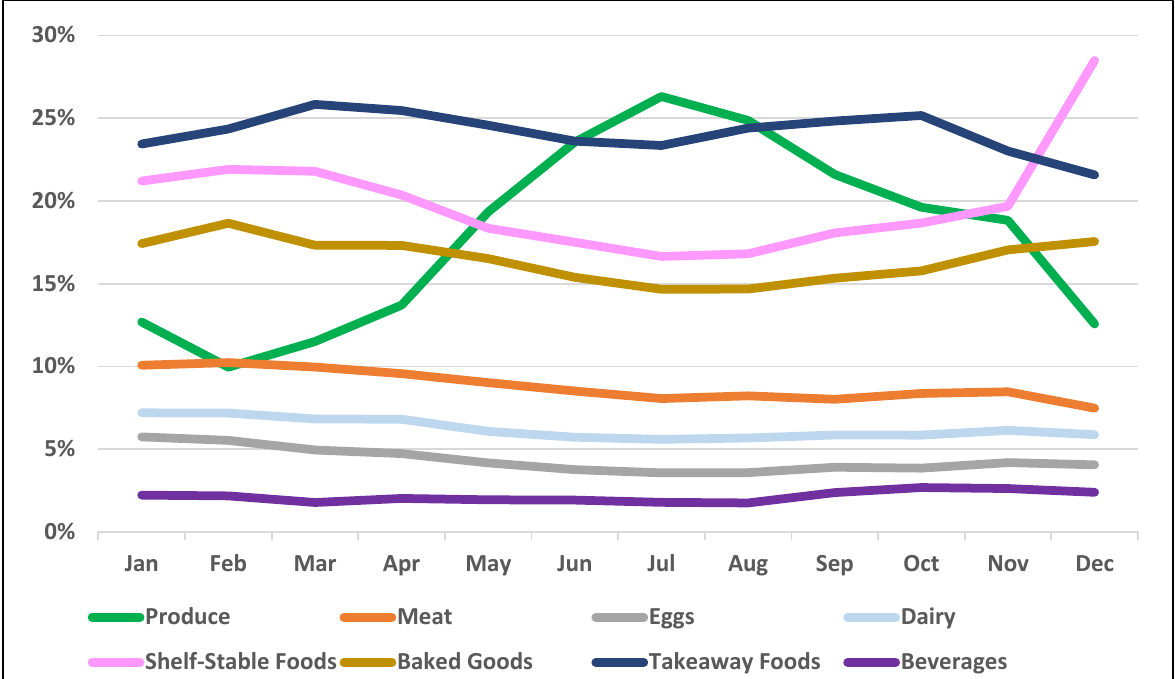
Figure 4. Sales by Category by Month, as Percentage of All Food Sales, 2011 –